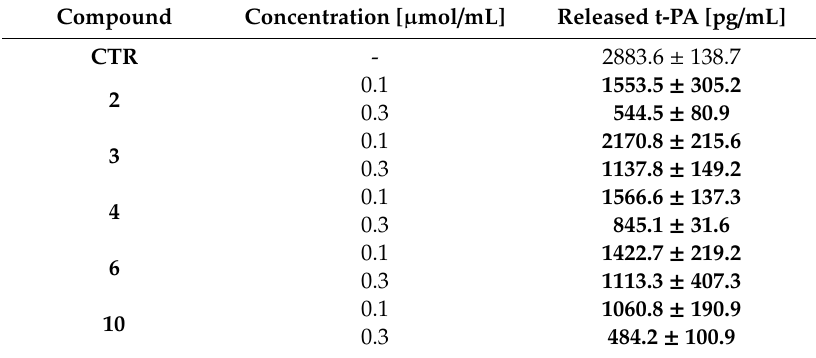
Table 4. The effects of selected sulfonamides on the release of t-PA from HUVEC cells. The results (t- PA concentration in supernatants, pg/mL) are presented as mean ± SD ( n = 6). Values in bold denote a significant difference between tested compounds and control samples ( p < 0.05).